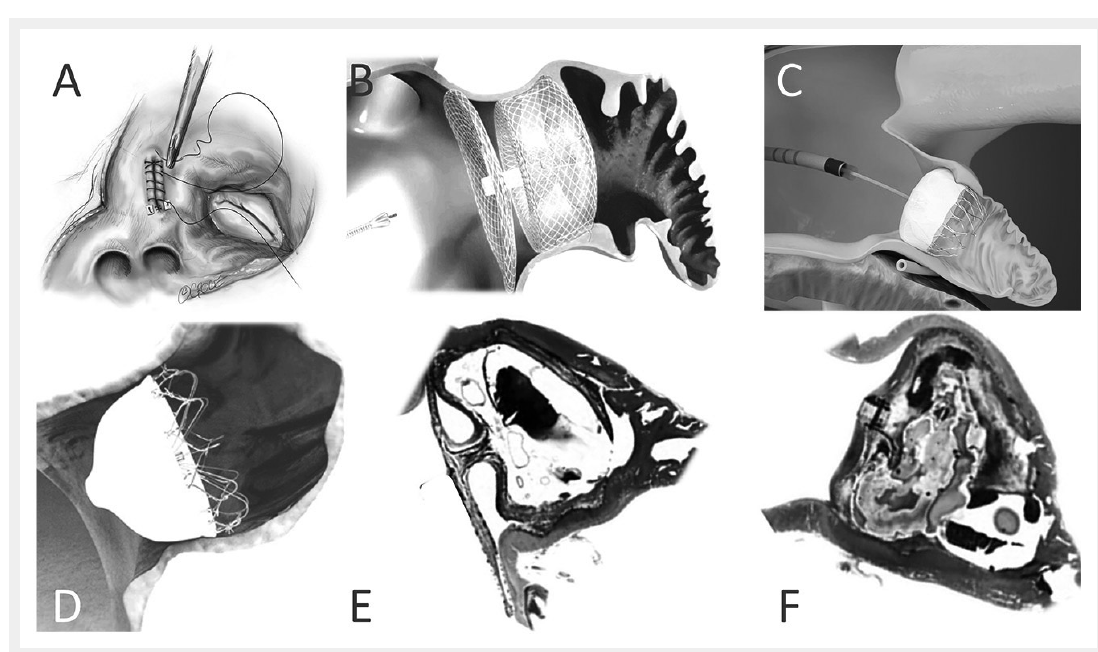
Different techniques, devices, and results for left atrial appendage closure (LAAC). In panel A, surgical endocardial closure by exclusion with a double layer suture is depicted. Note the proximity of the left atrial appendage (LAA) to the left pulmonary veins (LPVs) and the mitral valve (MV). Derived and modified from Robertson et al. [71] (© 2016 Beth Croce). In panels B and C, the two most common devices for percutaneous LAAC are shown (B: derived and modified from St. Jude Medical, Minnesota, USA; C: Image provided courtesy of Boston Scientific. © 2016 Boston Scientific Corporation or its affiliates. All rights reserved). In contrast to the Watchman, a membrane-cap device (C), the Amplatzer systems are plug-and-disc (pacifier) devices Panel D depicts another membrane-cap device, the Coherex Wavecrest (derived and modified from Coherex Medical, Utah, USA). In panels E and F, the Amplatzer and Watchman devices are shown after endocardialisation in anatomical preparations of canine models (derived and modified from Kar et al. [72] Impact of Watchman and Amplatzer devices on left atrial appendage adjacent structures and healing response in a canine model. JACC Cardiovasc Interv. 2014;7(7):801–9, with permission from